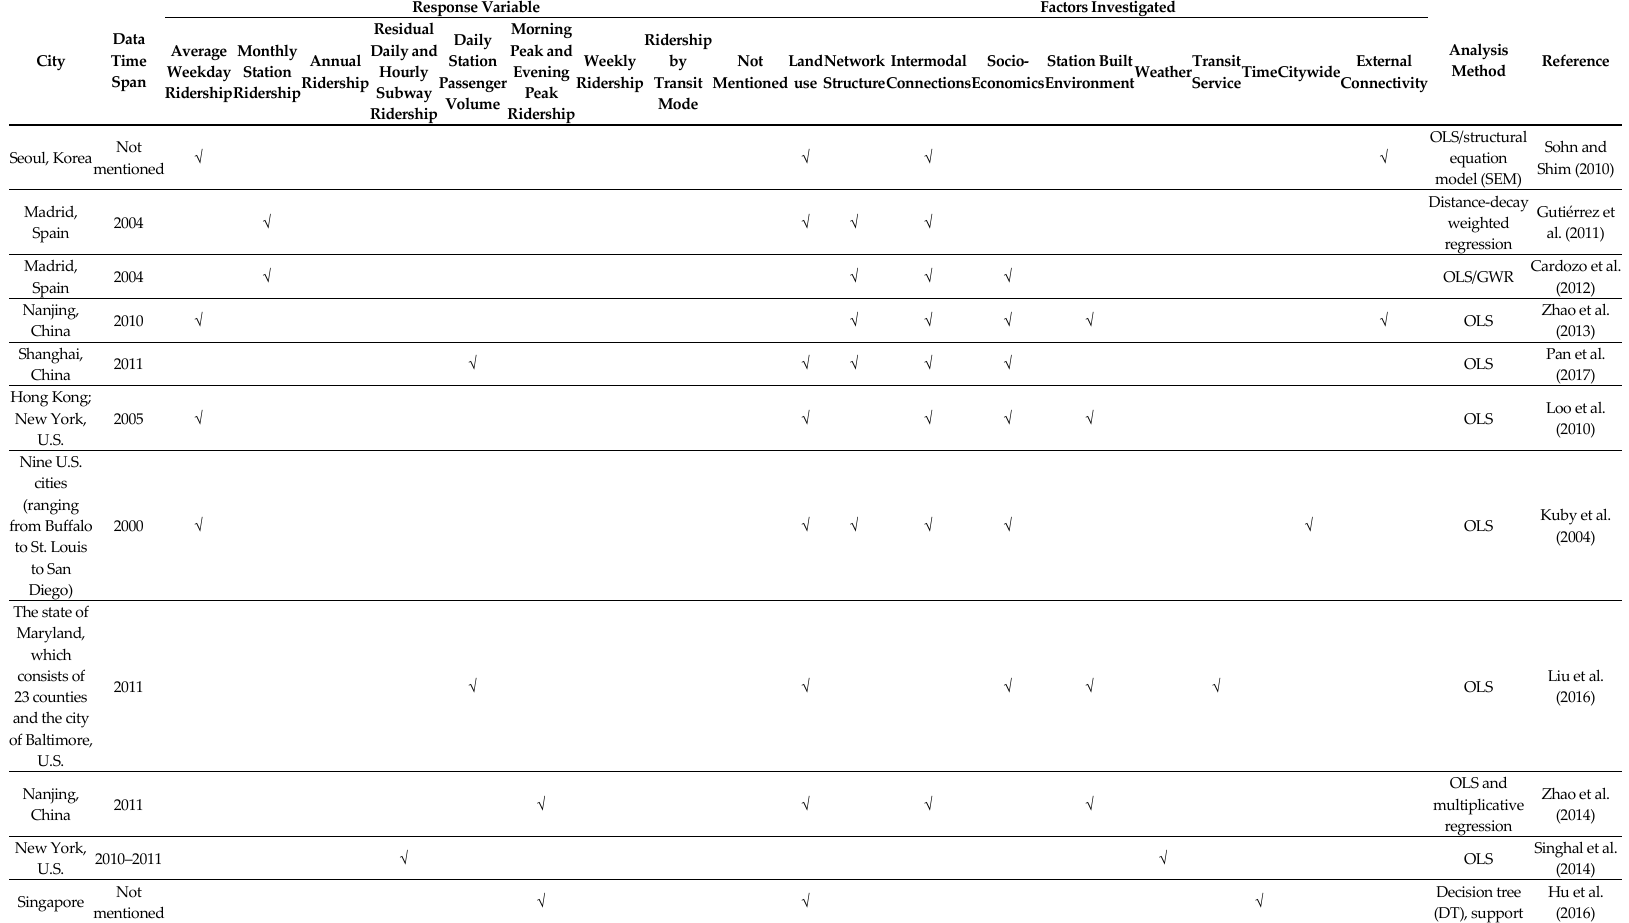
Table 1. A review of the literature related to transit ridership modeling [1–18,20–29].